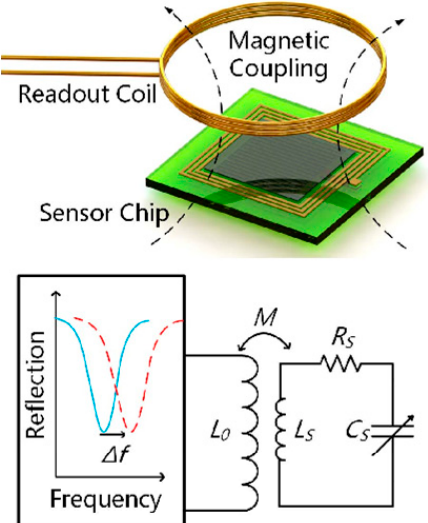
Figure 2. Graphical representation of LC passive wireless sensor system.